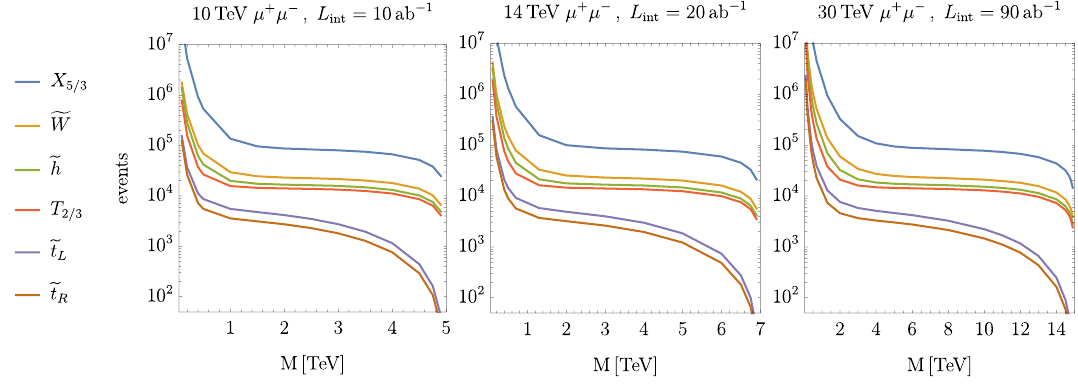
Figure 1 . Number of EW pair-production events, computed with MadGraph [15], using the Effective Photon Approximation for the calculation of the neutral VBF production cross-section. Namely, neutral VBF is evaluated as the sum of the 4 subprocess initiated by ‘ + ‘ − , ‘ + γ , γ‘ − , and p γγ , with a − Q 2 > 30 GeV cut on the virtual photons and the corresponding Q max = 30 GeV cutoff in the photon distribution function. The photon distribution function is the one for muons. The neutral VBF cross-section would thus be larger than what shown in the figure at the e + e − VHEL because of the smaller electron